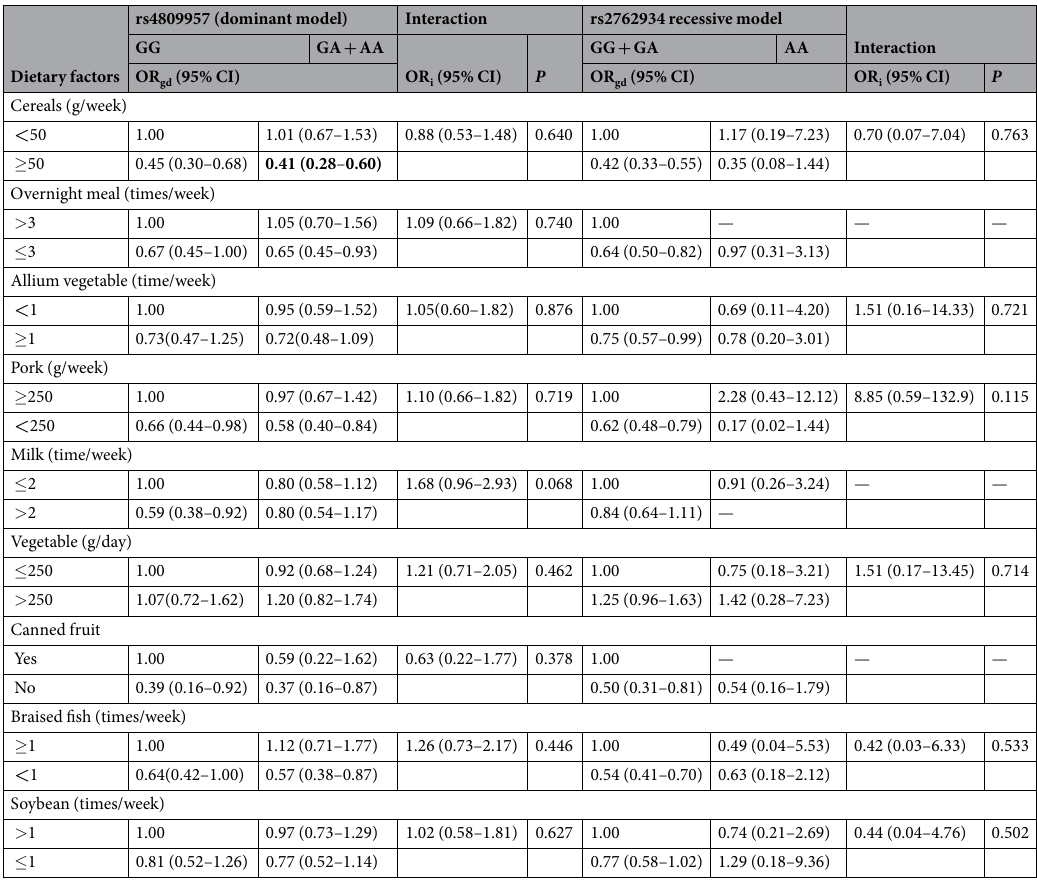
Table 4. Combined and interactive effects between polymorphisms in CYP24A1 and dietary factors in CRC. OR gd : OR genetic&dietary , combined effects of polymorphisms and dietary factors. OR i : OR interaction , interactive effects of polymorphisms and dietary factors. Note, we analyzed the combined effects for nine dietary factors and four polymorphisms of CYP24A1 and CYP27B1, the P value after Bonferroni correction is 0.05/36 = 0.0014. We analyzed the interactive effects using logistic regression, the significant P value of interactive effect is 0.05. * Bold values indicate significance after Bonferroni